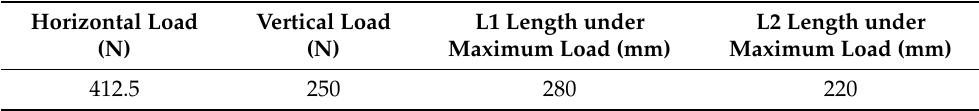
Table 4. The maximum load on the nut base during attitude adjustment.